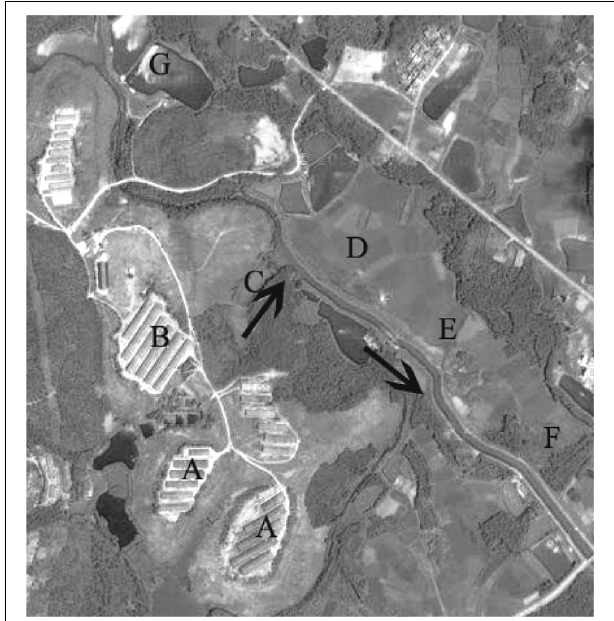
FIGURE 1 | Geographical map of the swine farm and its surrounding environment. The black arrow indicates the direction of effluent of swine manure water. Water and soil samples were collected from sites A to G. A, farrowing pen; B, nursery house; C, fish pond; D–F, agriculture fields; G,